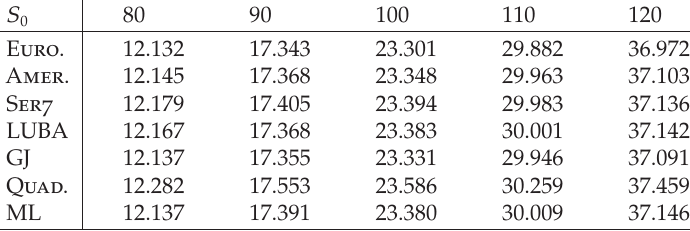
Table 2.6 . Call: Comparison with other methods; as in Table 2.5 but τ = 3 . 0. S